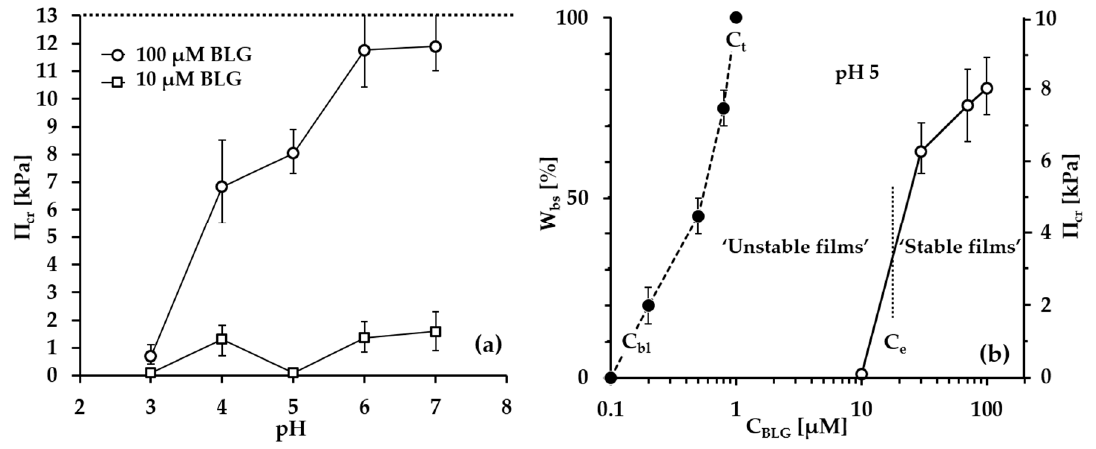
Figure 7. Black foam films obtained from solutions with different pH and C BLG (C buff = 10 mM). ( a )